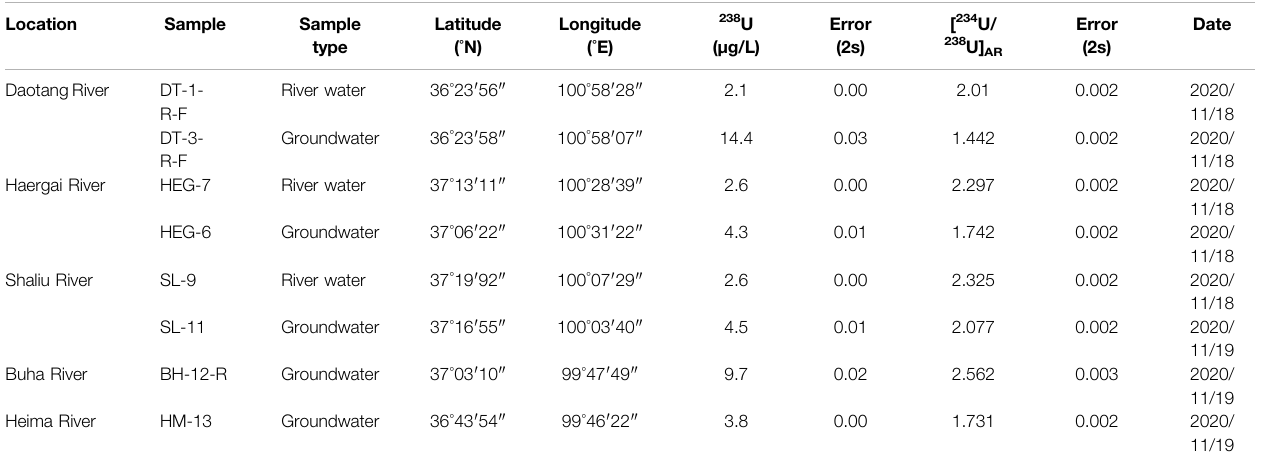
TABLE 5 | Results of inhouse freezing experiments on three batches of Qinghai Lake water samples collected during different seasons. Location Sample no